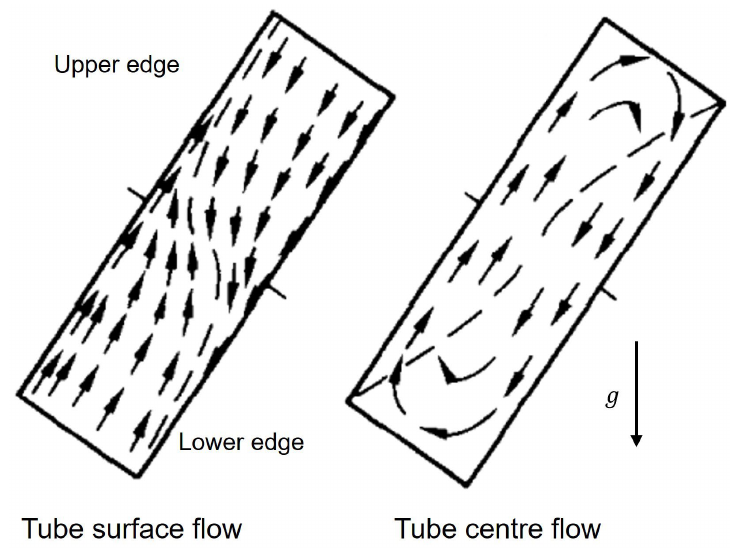
Figure 13. Flow pattern in the inclined closed single-phase thermosyphon [54].